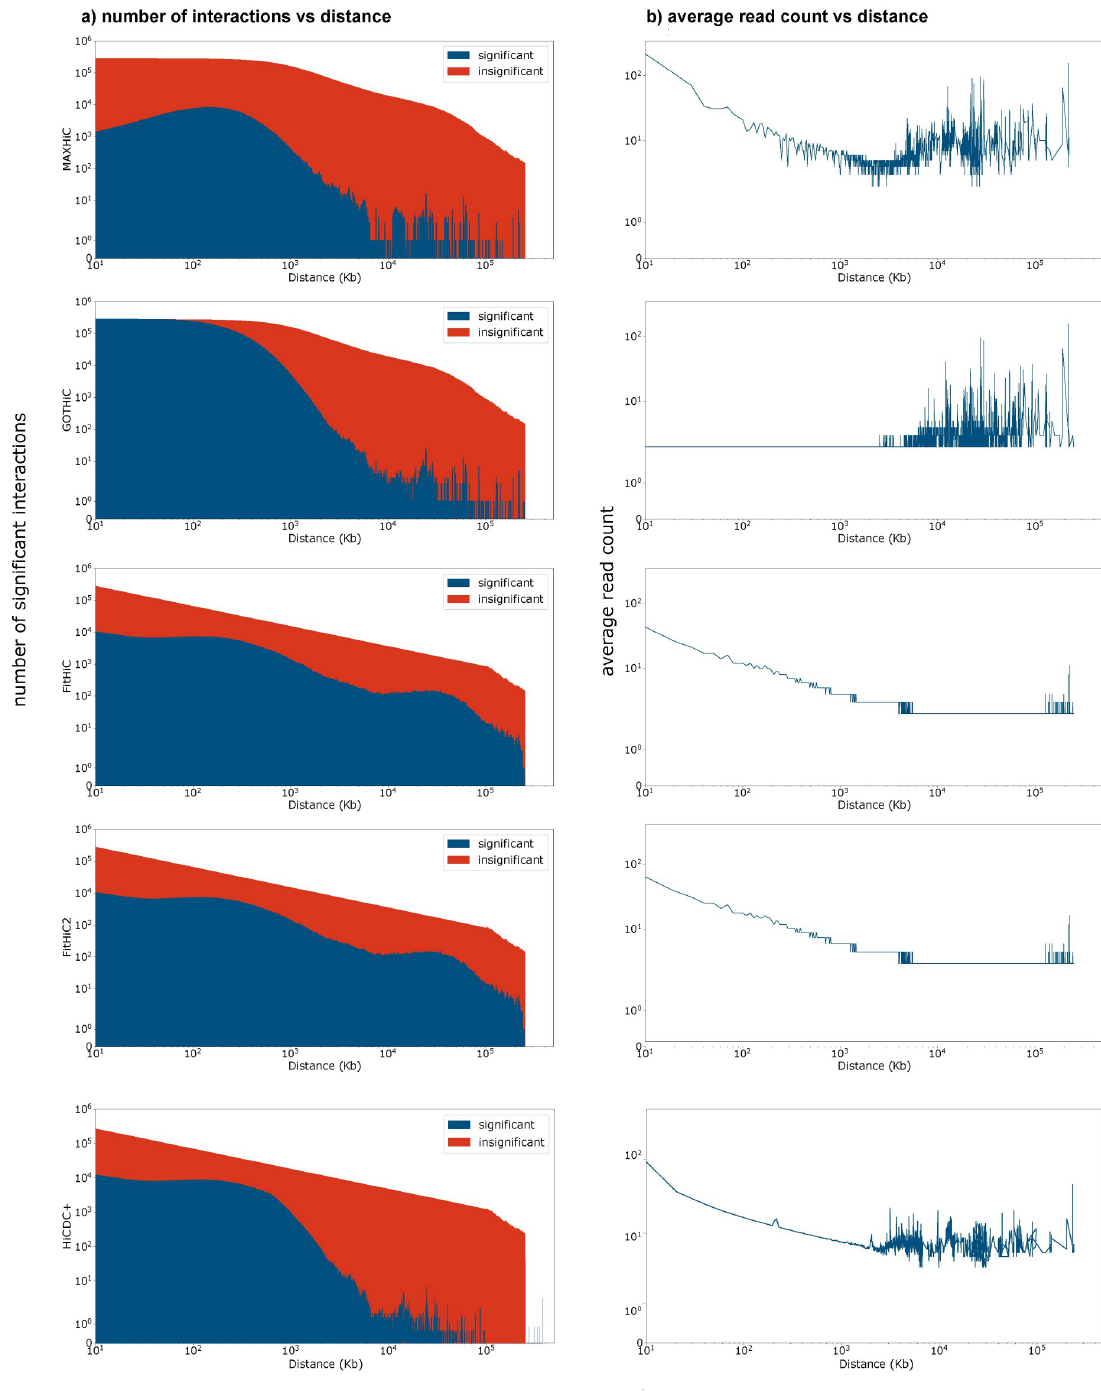
Fig 1. Background modelling as a function of distance in MaxHiC and other HiC tools. a) Average read-count of significant (blue) and insignificant interactions (red) at different genomic distances identified by different Hi-C interaction callers at 10kb bin size on the Rao et al . [5] GM12878 data. b) Number of significant interactions identified by the five Hi-C interaction callers in different genomic distances on Rao et al . GM12878 sample at fragment size 10kb.